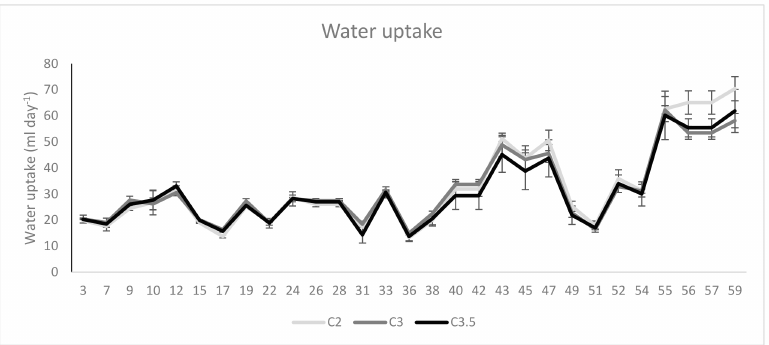
Figure 3. pH ( A ) and EC ( B ) of the leachate collated during the day after transplanting for the C2 (fertigation EC 2.0 dS m − 1 ), C3.0 (fertigation EC 3.0 dS m − 1 ), and C3.5 (fertigation EC 3.5 dS m − 1 ) treatments.